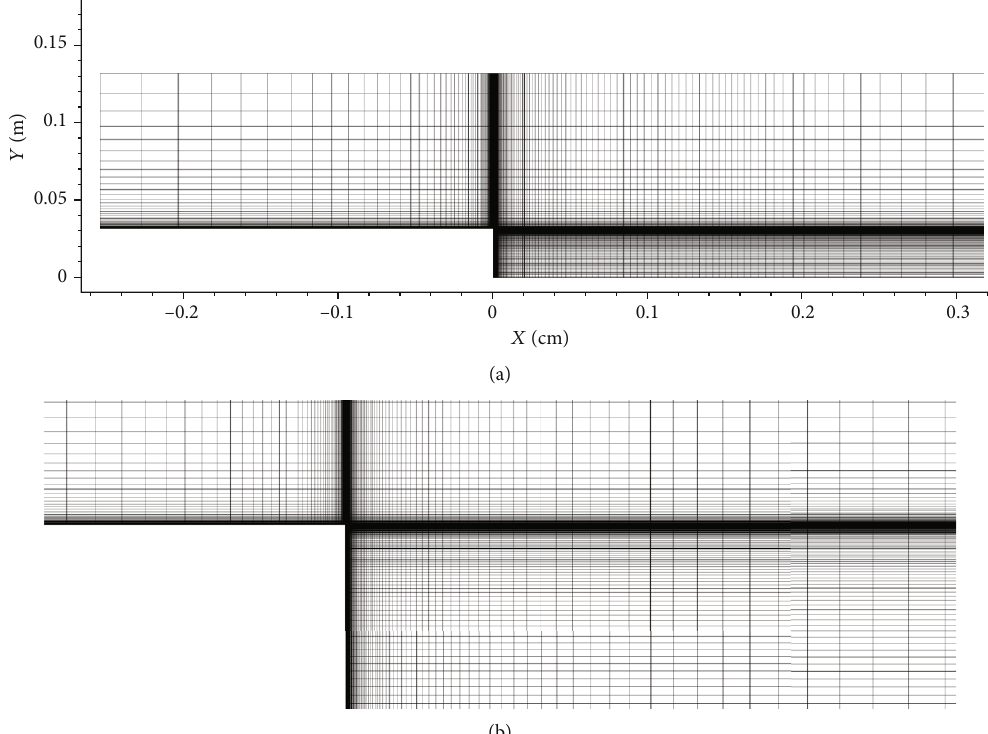
Figure 1: Axisymmetric base fl ow computational grid (a). Closeup view